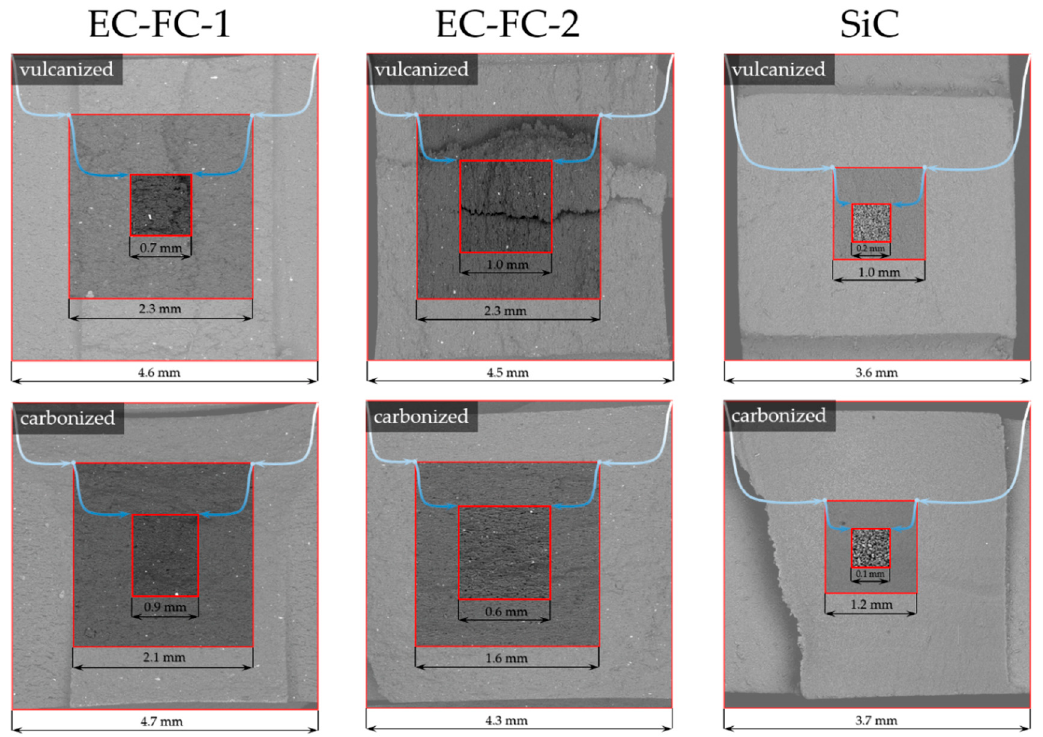
Figure 4. The microscopic appearance of sample fracture